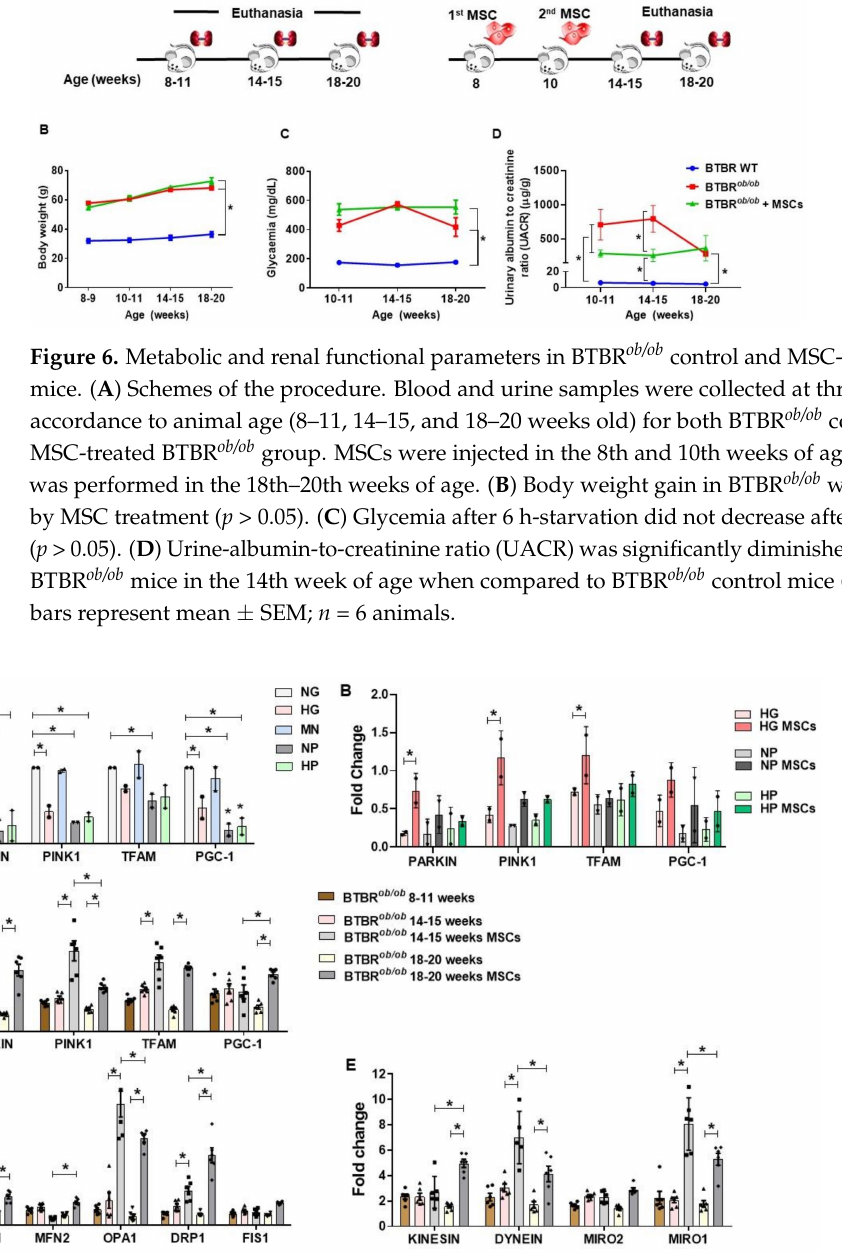
Figure 7. RNA expression of mitochondria quality control program (MQCP)-related genes in GMCs and in BTBR ob/ob mice’s kidney cortexes. ( A ) GMCs cultured in stress-conditioning media (HG, NP, and HP) presented a down-regulation in PARKIN and PINK1 gene expression at 72 h, whereas PGC-1 expression was only inhibited in NP and HP at 72 h (* p < 0.05). ( B ) MSCs treatment recovered PARKIN, PINK1, and TFAM gene expression in GMCs after HG 72 h-conditioning (* p < 0.05). ( C ) PARKIN, PINK1, TFAM, and PGC-1 genes had decreased expression in 14–15 and 18–20 week-old BTBR ob/ob mice kidney cortexes in comparison to 10–11 week-old mice. MSC treatment at 14–15 and 18–20 weeks of age upregulated PARKIN, PINK1, and TFAM ( p < 0.05). PGC-1 was upregulated only in MSC-treated 18–20 week-old mice (* p < 0.05). ( D ) DRP1 and OPA1 had increased gene expression in 14–15 and 18–20 week-old MSC-treated BTBR ob/ob mice kidney cortexes ( p < 0.05). MFN1 only had increased gene expression in 18–20 week-old MSC-treated BTBR ob/ob mice kidney cortexes ( p < 0.05). ( E ) DYNEIN and MIRO1 had increased gene expression in 14–15 and 18–20 week-old MSC-treated BTBR ob/ob mice kidney cortexes (* p < 0.05). KINESIN had only increased gene expression in 18–20 week-old MSC-treated BTBR ob/ob mice (* p < 0.05). Our qRT PCR results (2 ∆∆ Ct ) were normalized to BTBR wild-type mice at each related age (10–11, 14–15, and 18–20 week-old). Error bars represent mean ± SEM. For GMCs qRT PCR assays, n = 2. For BTBR mice qRT PCR assays, n =